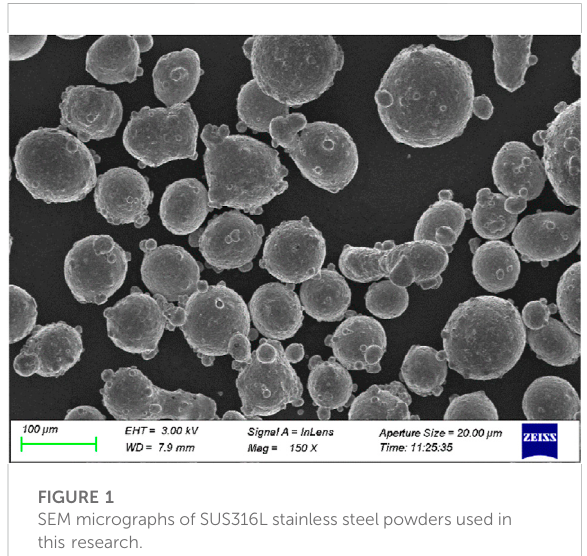
FIGURE 1 SEM micrographs of SUS316L stainless steel powders used in this